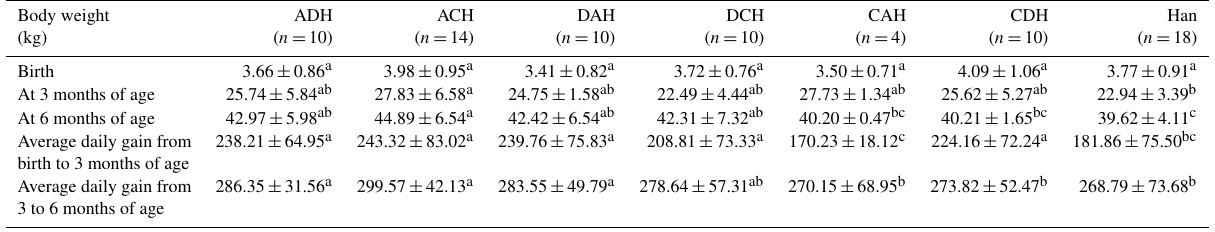
Table A2. The result of variance analysis of body weight parameters of three-way crossbred and Han lambs (mean ± standard deviation).